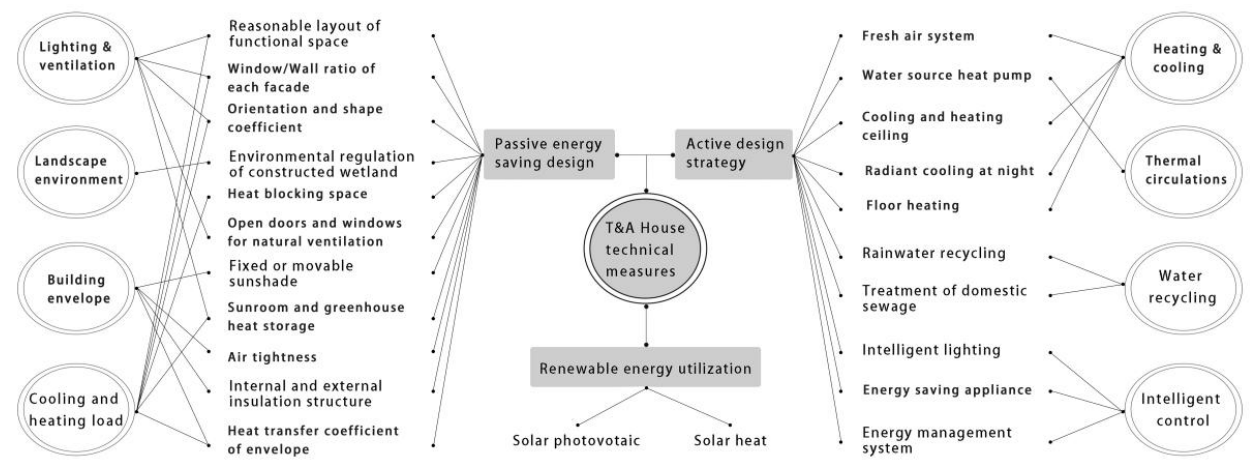
Figure 1. T&A House’s technical measures.